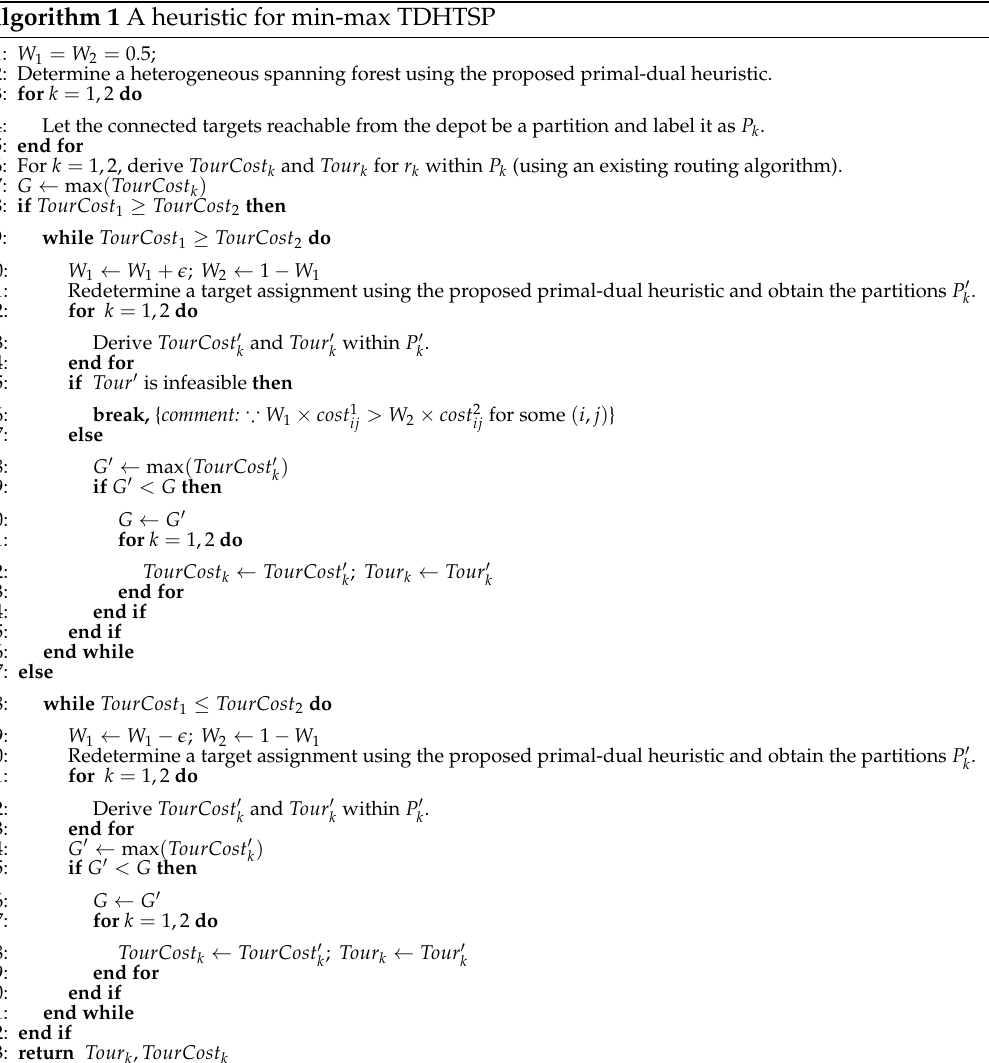
Algorithm 1 A heuristic for min-max